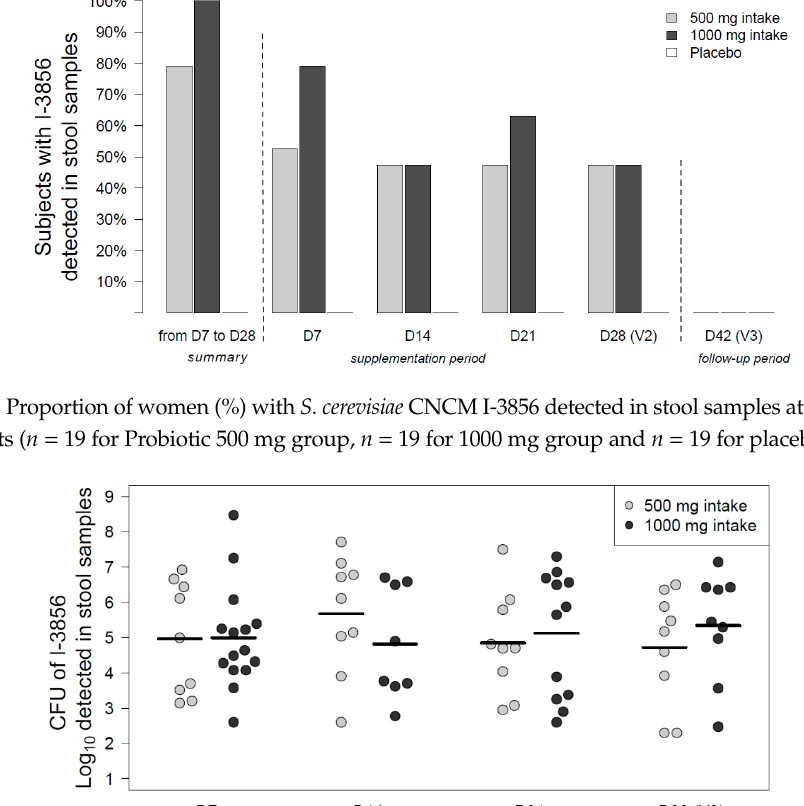
Figure 5. Estimated CFU counts of S. cerevisiae CNCM I-3856 detected in stool samples at each study timepoint expressed as log10 CFU/sample. Only the samples in which the yeast was detected are figured in this plot.